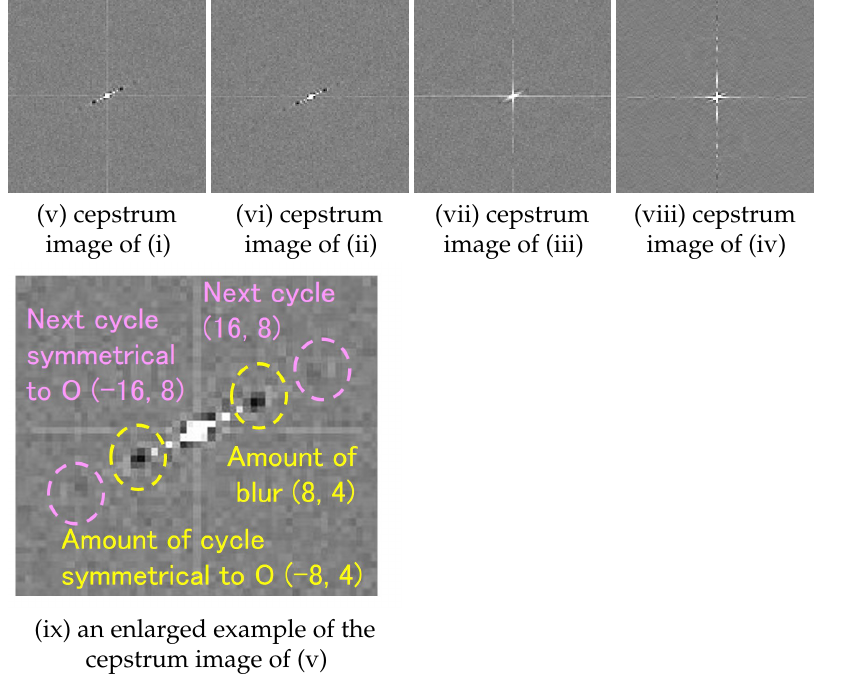
Figure 7. Examples of com-degraded image(9 pixels, 26 degrees) and cepstrum image from area A to D (121 × 121 pixels). Table 6. The blur amount (7 pixels, 45